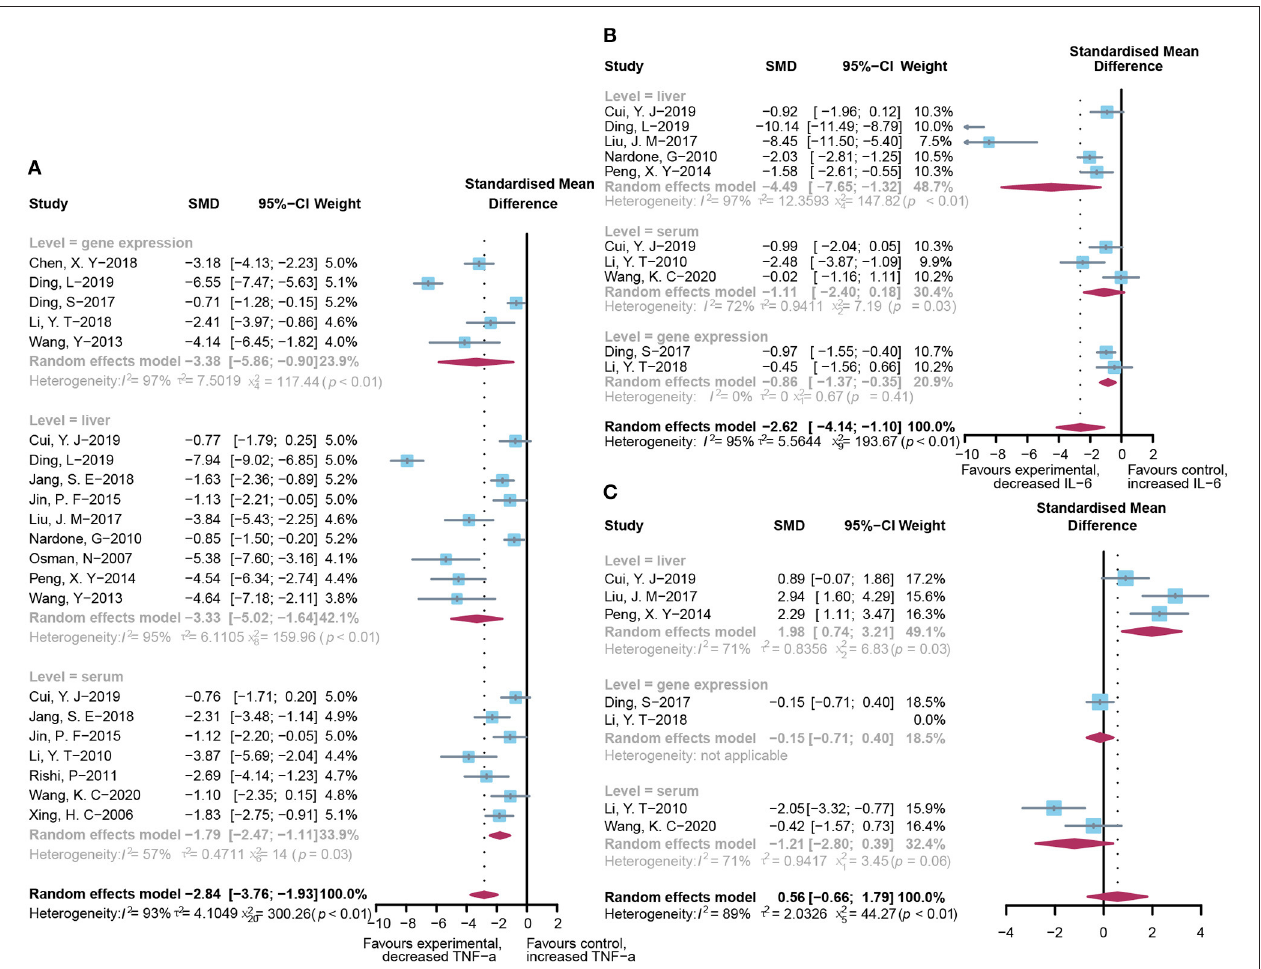
FIGURE 5 | Effectiveness of microbial agents on inflammatory cytokines. (A) The effect of microbial agents on TNF- α . (B) The effect of microbial agents on IL-6. (C) The effect of microbial agents on